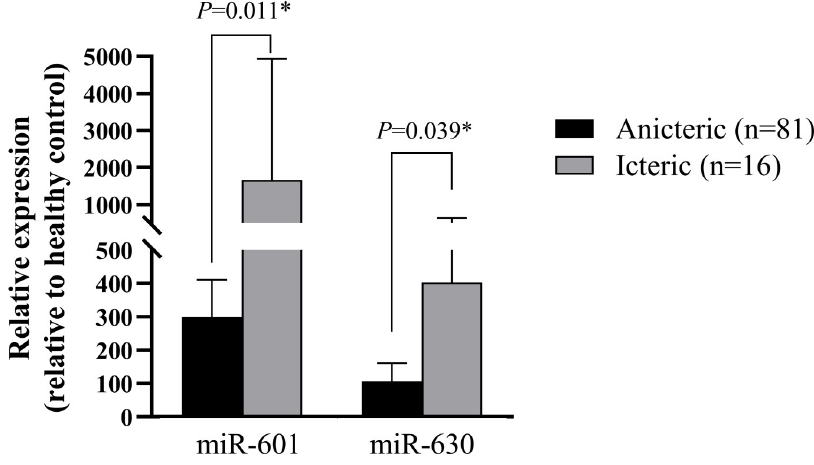
Fig 2. Relative expression of serum miR-601 and miR-630 in patients with the anicteric and icteric groups.